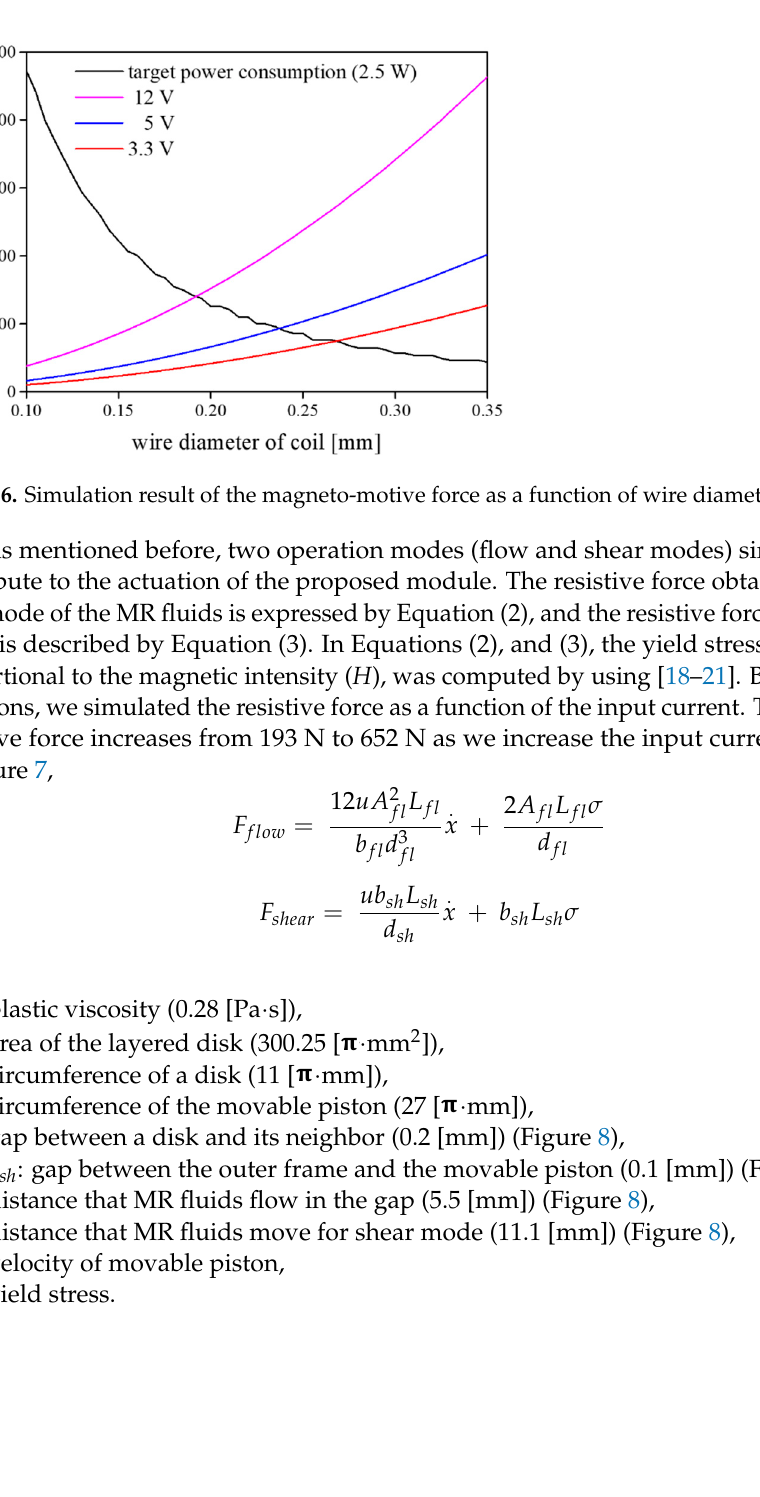
Figure 7. Simulated resistive force as a function of input current. Figure 8. Variables for computing resistive force.